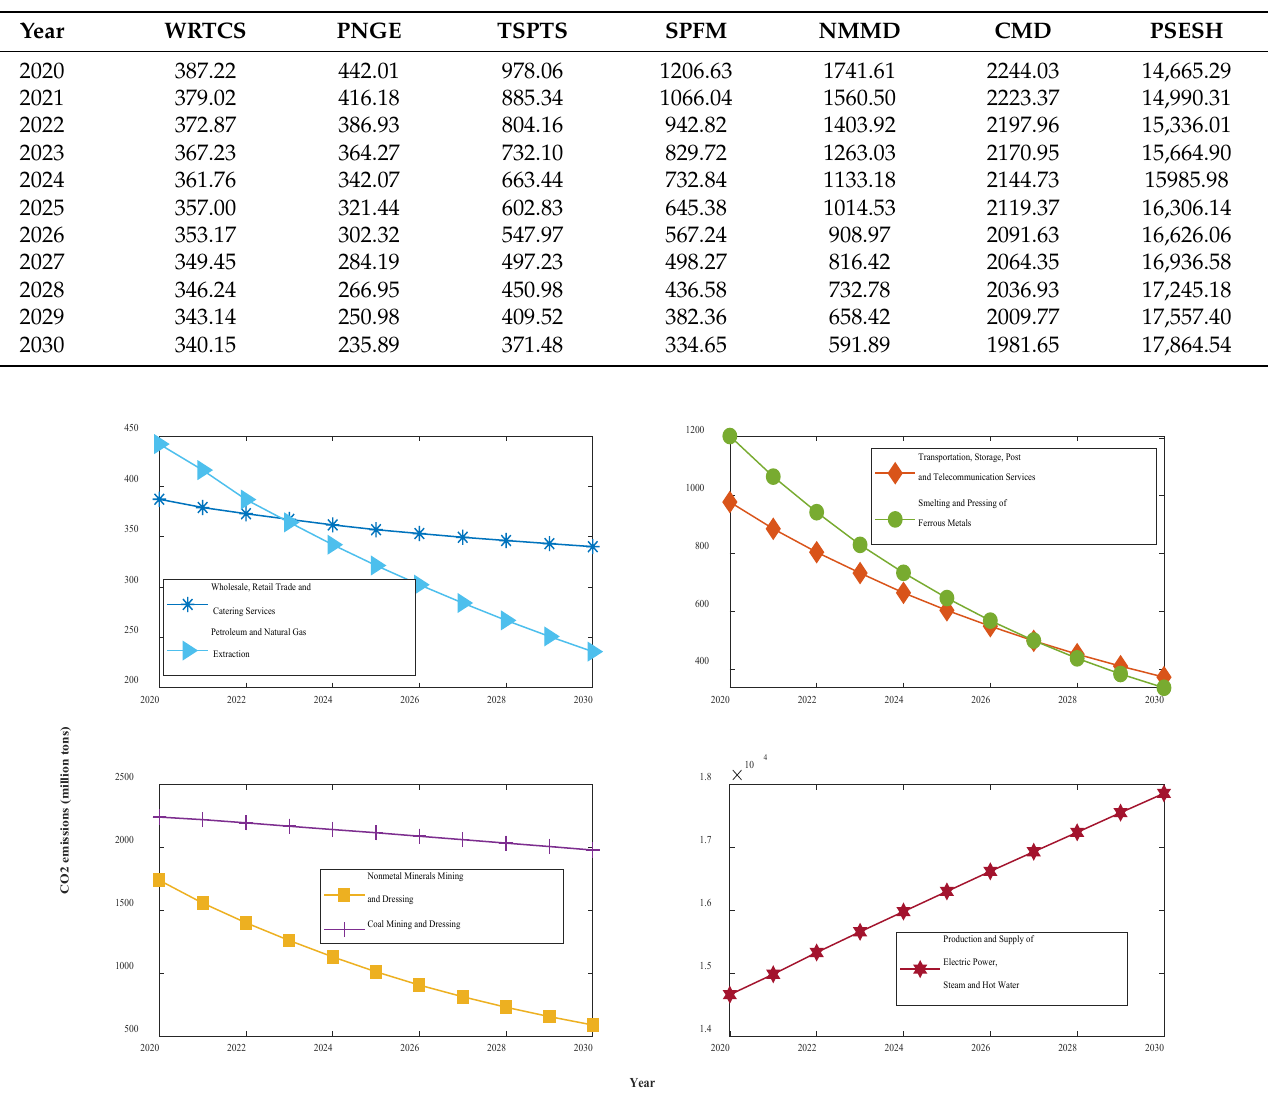
Figure 10. CO 2 emissions curves for the next 11 years in Shaanxi. The forecasting results show that under the various grey conditions in effect, CO 2 emissions are projected to decline in all six sectors—WRTCS, PNGE, TSPTS, SPFM, NMMD, and CMD—and to further increase in the PSESH sector. CO 2 emissions in WRTCS are projected to decline at an average rate of 1.3% per year and are projected to decline by 55.5 million tons. CO 2 emissions in PNGE are projected to decline at an average rate of 4.6% per year and are expected to decline by 2.39 million tons by 2030. CO 2 emissions in TSPTS are projected to decline at an average rate of 5.9% per year and are expected to decline